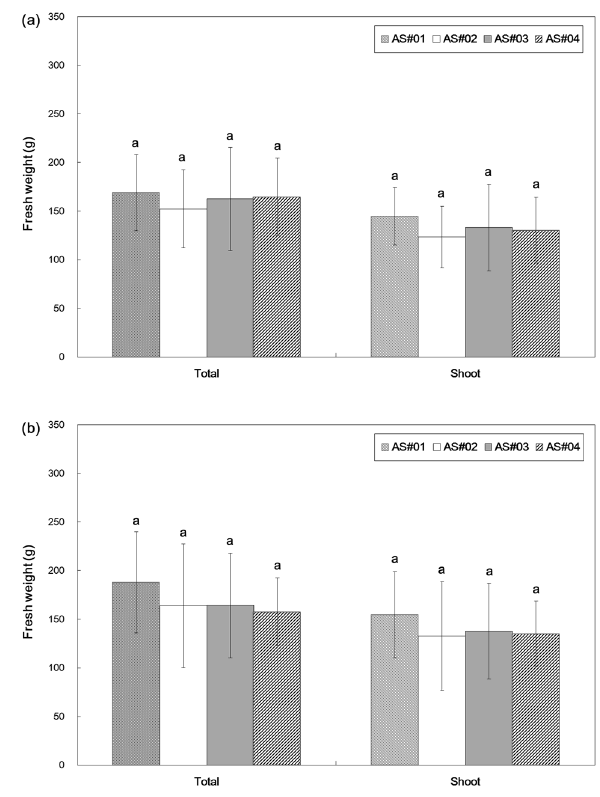
Figure 6. Effect of desalinated irrigation water on lettuce shoot and total fresh weights after the ( a ) first and ( b ) second phases of the experiment. Bars represent the mean ± standard deviation, n = 20. Different letters indicate significant differences among treatments by Tukey’s honest significant difference test at p < 0.05. AS: after water treatment using the BWD system, i.e., desalinated water irrigation.